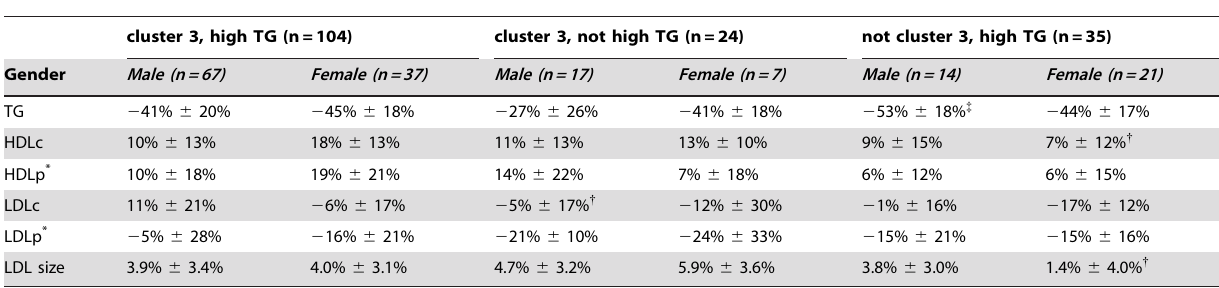
{ indicates significantly different with respect to cluster 3 and high TG subgroup, p , 0.01. { indicates significantly different with respect to cluster 3 and not high TG subgroup, p , 0.01.